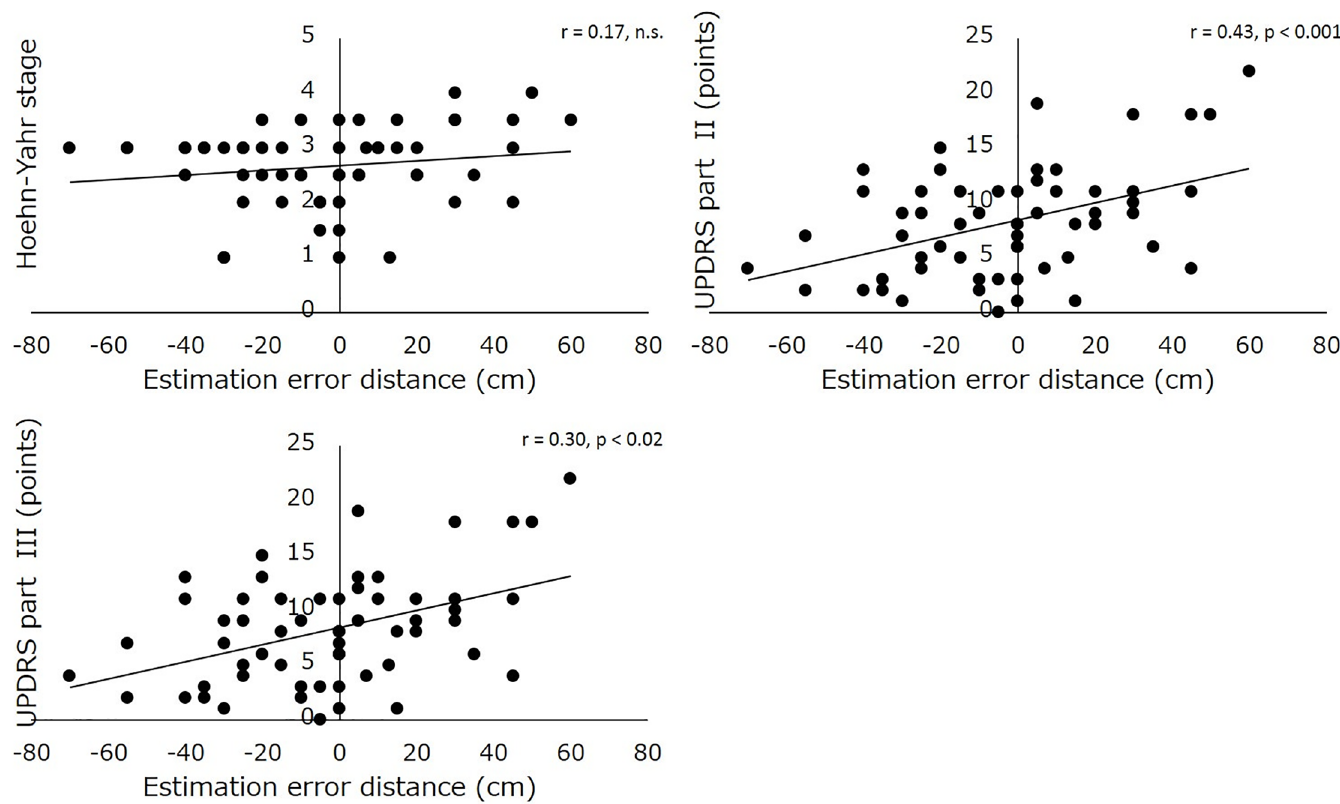
Fig 2. Scattergrams of the estimation error distance, and H&Y stage (upper left), and UPDRS part II (upper right) and III (lower).